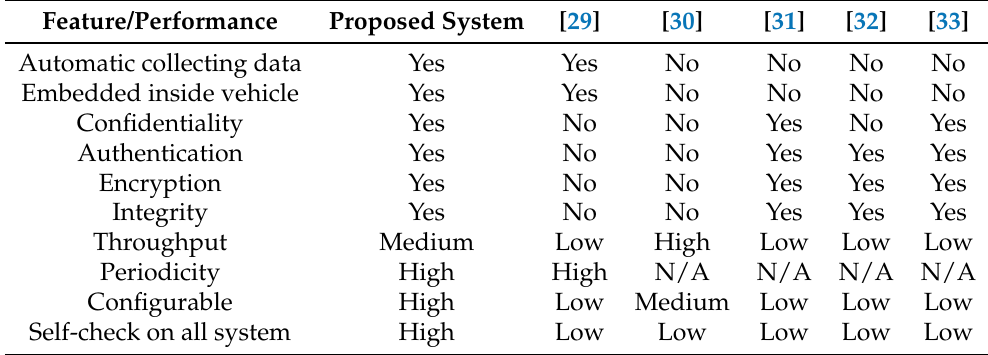
Table 4. Feature/performance comparison between the proposed and existing